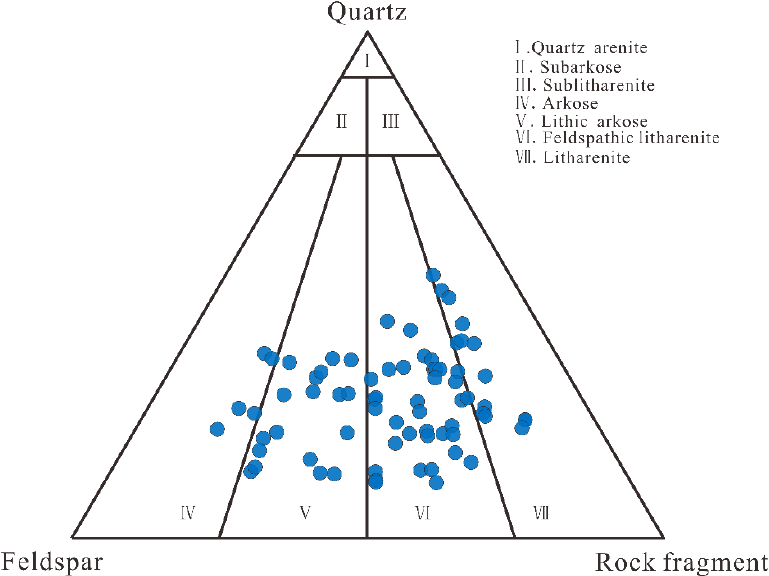
Figure 3. Ternary diagram of detrital compositions of the sandstones in the Lower Jurassic reservoir in Niudong based on the Folk (1980) sandstone classification [50].